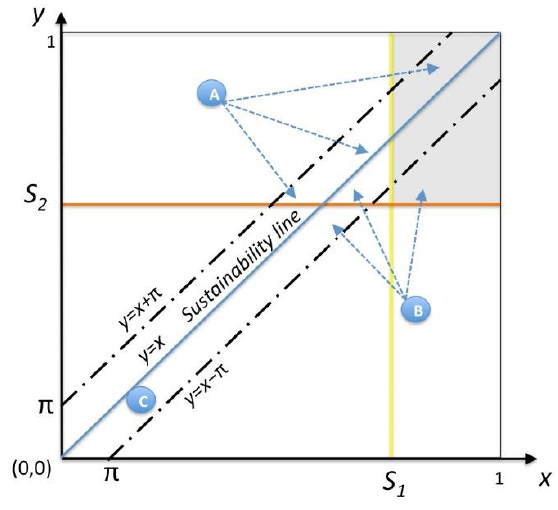
Figure 3. Transformation paths.